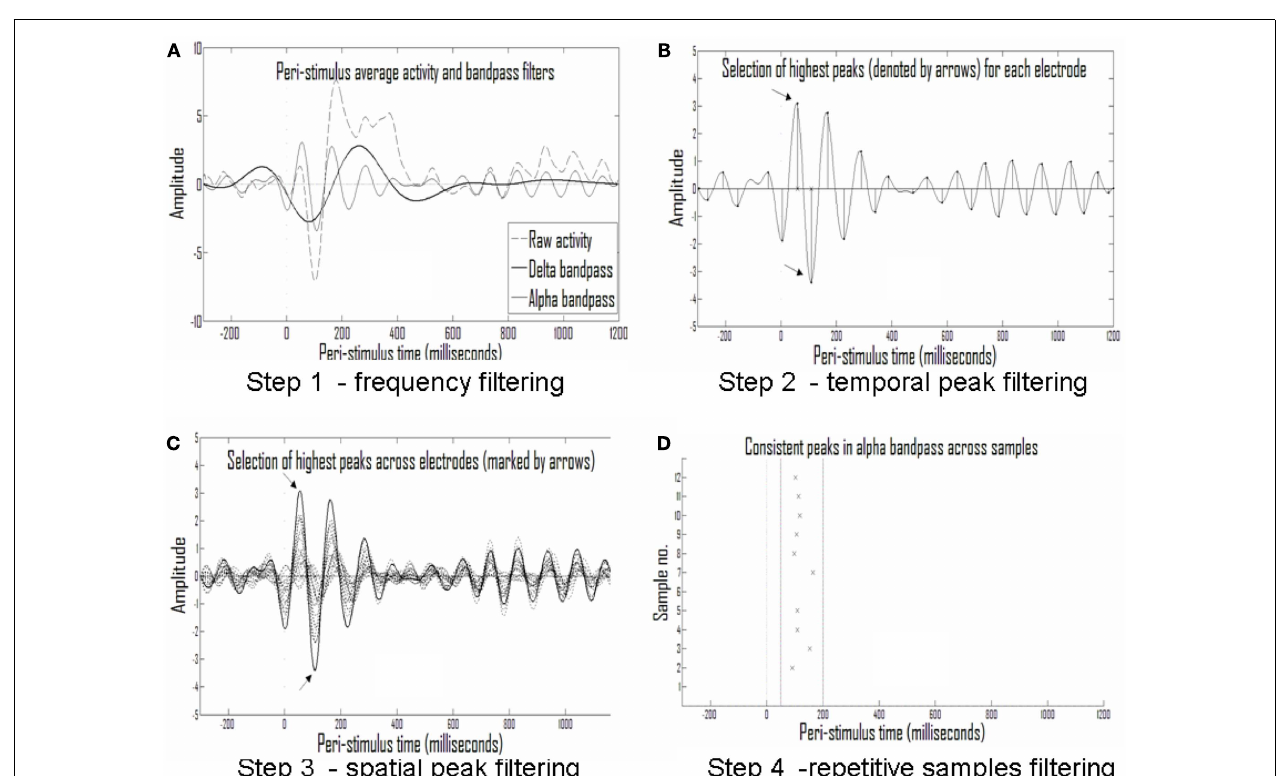
largest in activity compared with simultaneous activity in other electrodes are selected. (D) Only peaks that are repetitive across samples from the same experimental group (with temporal tolerance) are selected as repetitive